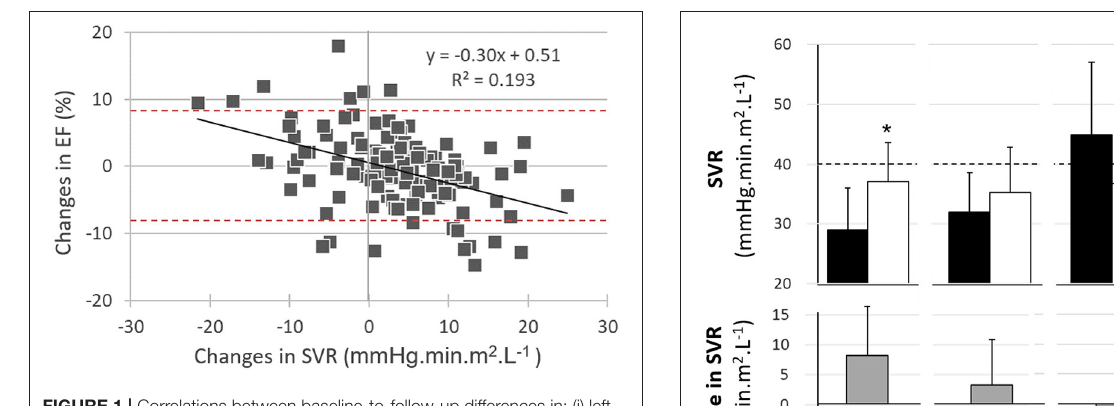
FIGURE 1 | Correlations between baseline-to-follow-up differences in: (i) left ventricular ejection fraction (EF changes) and (ii) systemic vascular resistance (SVR changes). It may additionally be observed that many EF changes are outside of the − 8% to + 8% interval (red dashed lines) and may thus be considered significant.